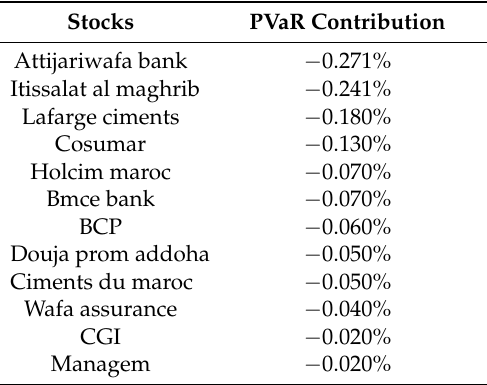
Table produced on Excel under VBA by the